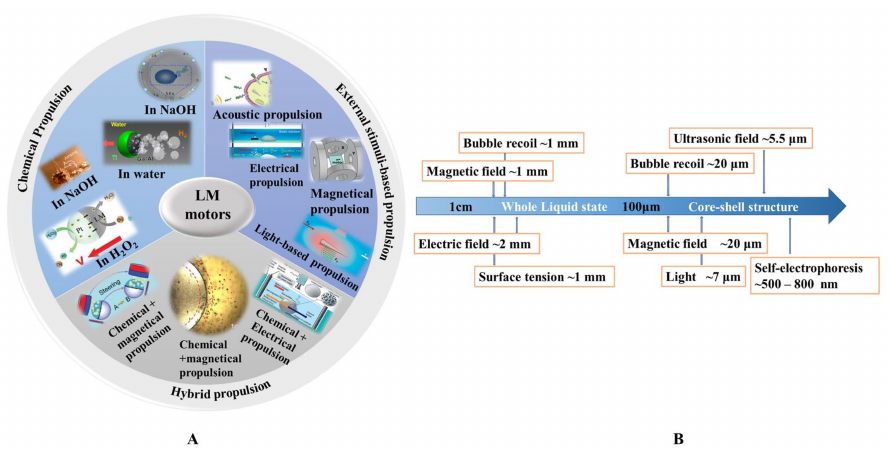
Figure 1. The propulsion mechanism of LM motors. ( A ) LM motors propelled by different energy sources. ( B ) The relationship between the size of LM motors and corresponding driving force. Table 2. Overview of different propulsion methods of mini/micro/nano scale liquid metal motors (MLMTs). -